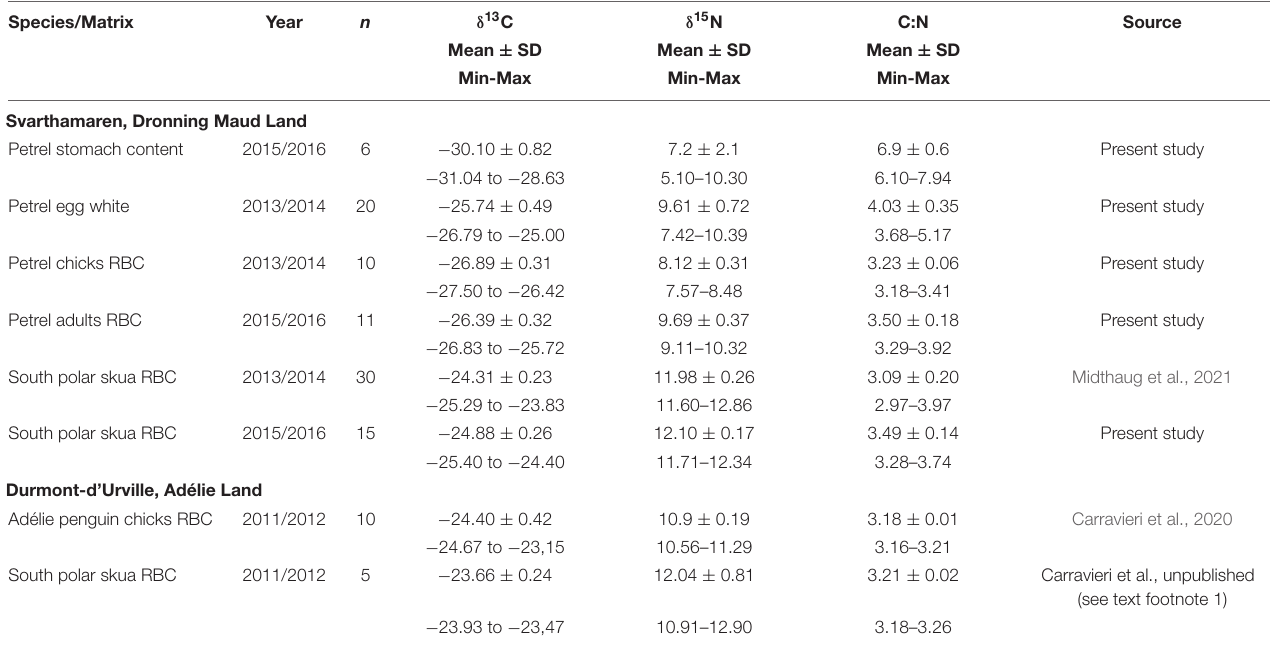
TABLE 2 | Bulk isotopic values measured in Antarctic petrel stomach content, egg white, chick, and adult red blood cells (RBCs) and Adélie penguin chick RBC and south polar skua RBC in Antarctica during specified breeding seasons. Species/Matrix Year n δ 13 C δ 15 N